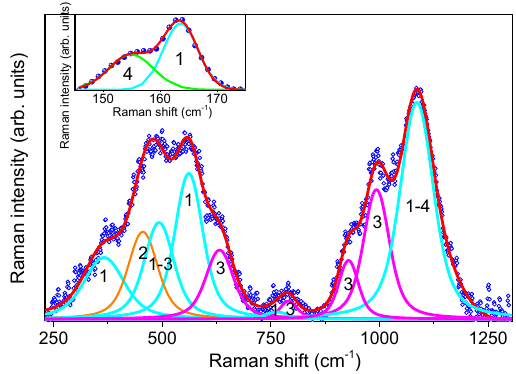
Fig. 5. Experimental Raman spectrum of the light-blue glazed surface collected in the 250-1300 cm -1 range and, in the inset,